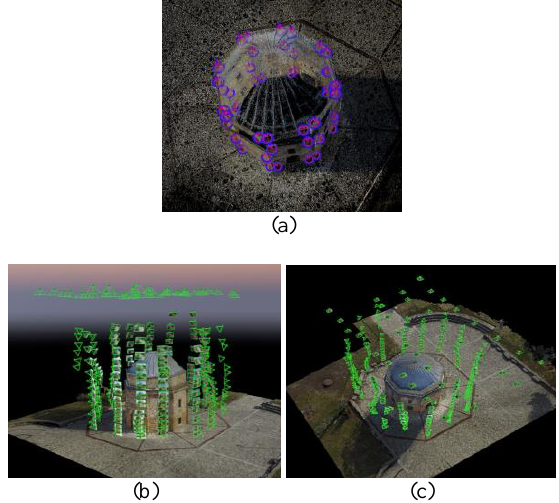
Figure 3. (a) GCPs distribution over the object (b) and (c) image network for SfM